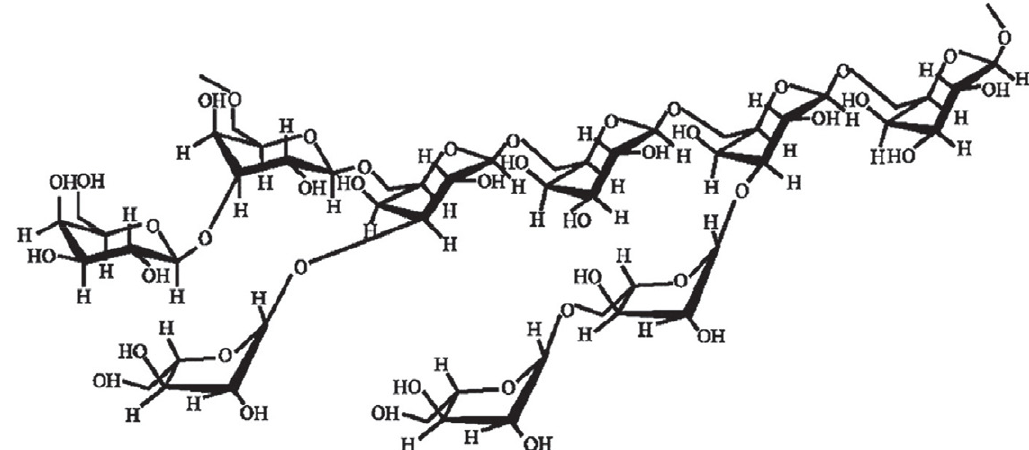
Figure 1. The chemical structure of